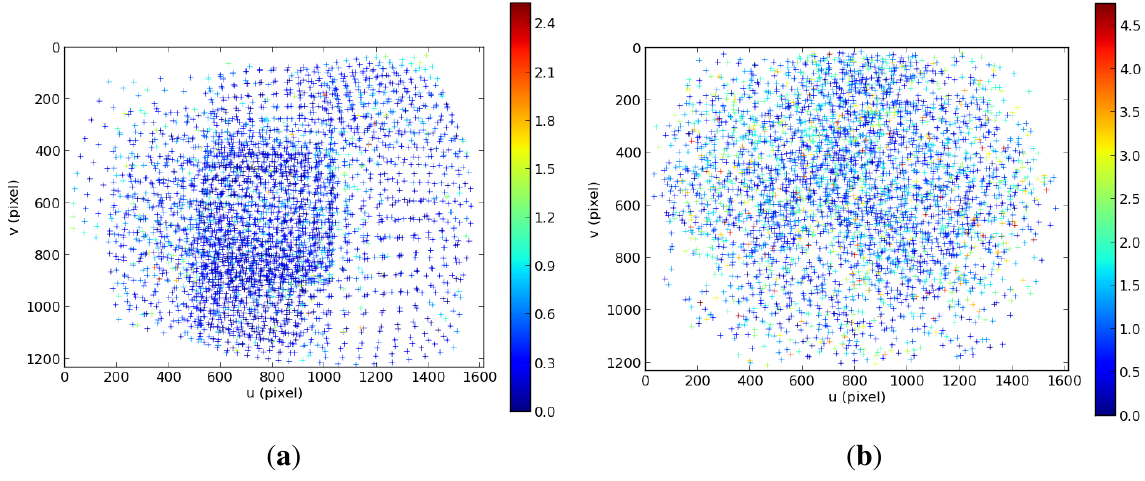
Figure 17. Comparison between the location of the features and its re-projection error in the initialization ( a ) and refinement step ( b ) for the intrinsic calibration of Camera 5 (2.95-mm focal